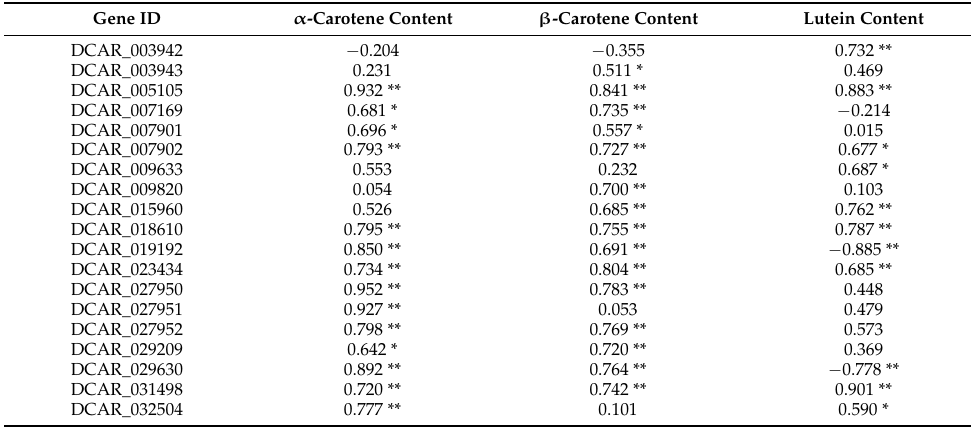
Table 1. Correlation between the expression levels of 19 photosynthesis-related genes and carotenoid content in different